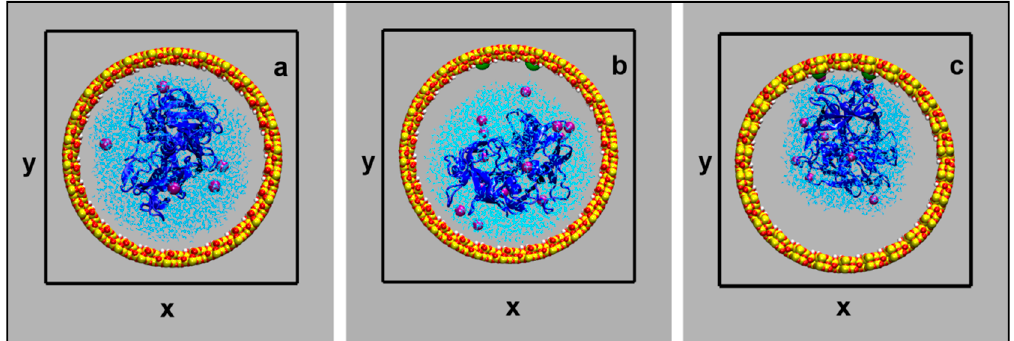
Figure 11. Projection of the simulation cells on the xy plane: neutral surface ( a ); charged surface ( b , c ). The partially dehydrated model is shown in picture c. The water droplet (light blue lines) contains pepsin (blue ribbon structure) and potassium cations (purple spheres). The silica slab atoms are represented as spheres (color codes: Si, yellow; O red; H, white; silanolates, green. The snapshot represents the starting configuration for Model 1 ( a ), Model 2 ( b ), and Model 3 ( c ). The orthorhombic unit cell of 10.04 × 10.04 × 16.06 nm 3 is represented as black